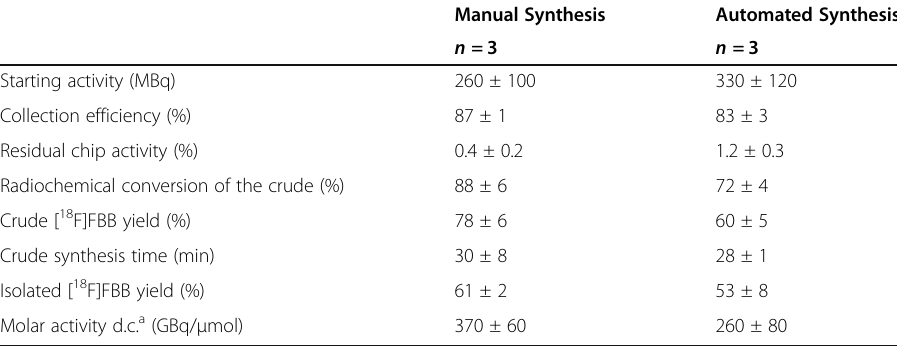
Table 1 Summary of synthesis performance when performed manually or on the automated setup. All % values are calculated in reference to starting